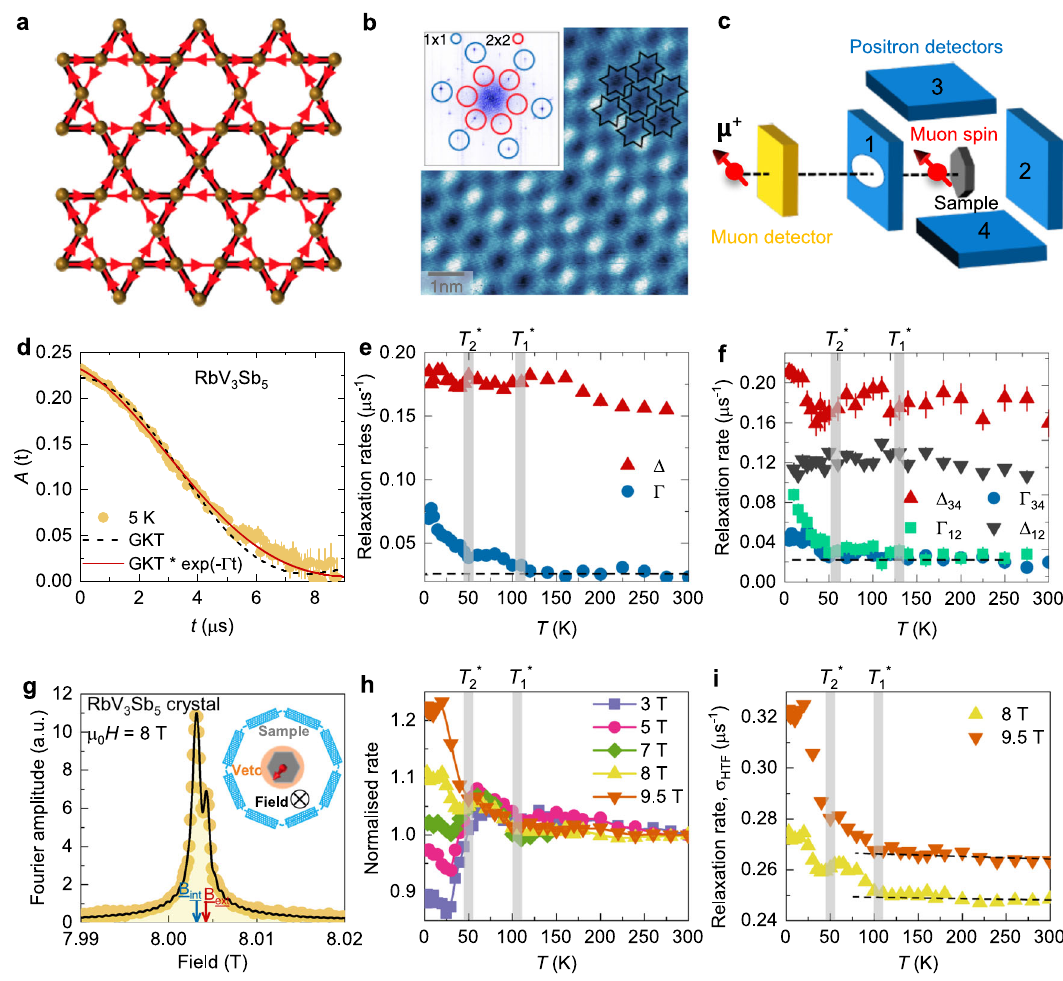
Fig. 1 | Time-reversalsymmetry-breaking chargeorderinRbV 3 Sb 5 . a Schematic example of an orbital current state (red arrows) in the kagome lattice. b Scanning tunnelingmicroscopyoftheSbsurfaceshowing2×2chargeorderasillustratedby black lines. The inset is the Fourier transform of this image, displaying 1×1 lattice Braggpeaks(bluecircles)and2×2charge-orderpeaks(redcircles).Thelatterhave different intensities, suggesting a chirality of the charge order. c A schematic overviewoftheexperimentalset-up(seethe “ Methods ” section). d TheZF μ SRtime spectra for the polycrystalline sample of RbV 3 Sb 5 , obtained at T =5K. The dashed and solid curves represent fi ts using the Gaussian Kubo – Toyabe (GKT) function without(black)andwith(red)amultipliedexponentialexp ð(cid:2) Γ t Þ